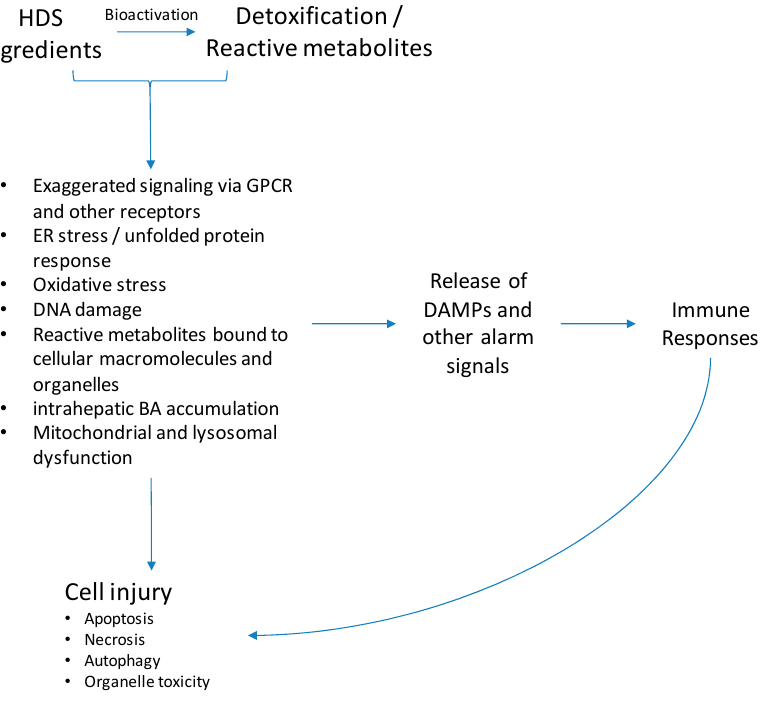
Figure 4. Potential mechanisms of HDS-induced liver injury. Most HDS hepatotoxicity develops through direct hepatocyte toxicity or by triggering an immune response. Toxic ingredients or their reactive metabolites cause direct hepatocyte toxicity through various mechanisms, such as oxidative stress, endoplasmic reticulum (ER) stress, DNA damage, toxic bile acids accumulation, and mitochondrial dysfunction, consequently leading to cell apoptosis or necrosis. Another important mechanism resulting in cell damage occurs when either toxic HDS ingredients, reactive metabolites, or danger damage-associated molecular patterns (DAMPs) released by stressed hepatocytes trigger an immune response. The exact mechanism leading to HDS-hepatotoxicity is still under investigation and other pathways may be involved.